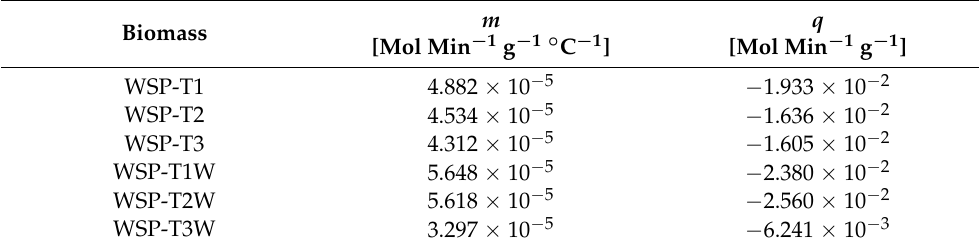
Table 5. Slopes ( m , Equation (7)) and y-axis intercepts ( q , Equation (7)) of the regression straight lines of SMGP (Equation (6)) for torrefied and torrefied-washed